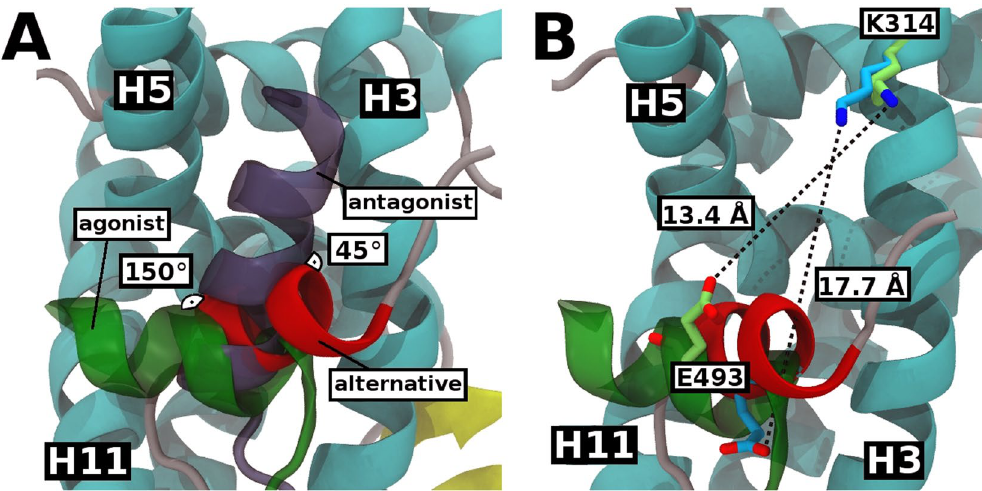
Figure 3. Comparison of the alternative, canonical agonist and antagonist bound structures: ( A ) Angle displacement between H12 position of alternative ER β LBD-E2 (red), canonical agonist ER β LBD-E2 (green, PDB code 3OLS) and antagonist ER β LBD-genistein (purple, PDB code 1QKM) structures. Alternative structure appears to be in a similar position to the antagonist structure. ( B ) Distance between the charge-clamp residues (K314 and E493) of alternative ER β LBD-E2 (H12 in red, residues in cyan) and canonical agonist ER β LBD-E2 (H12 and residues in green, PDB code 3OLS). The charge clamp of canonical conformation is an optimal distance, since the structure was associated with a coactivator